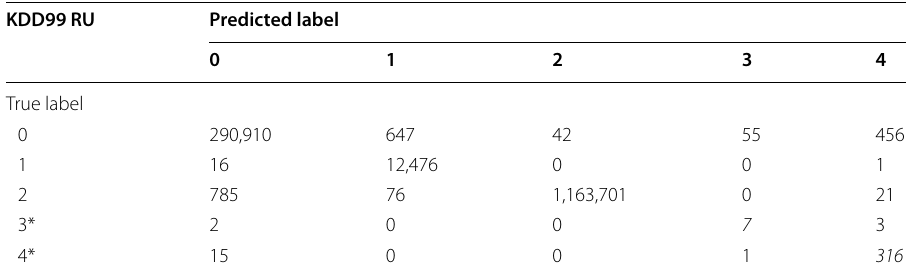
Table 14 Confusion Matrix: KDD99 RU KDD99